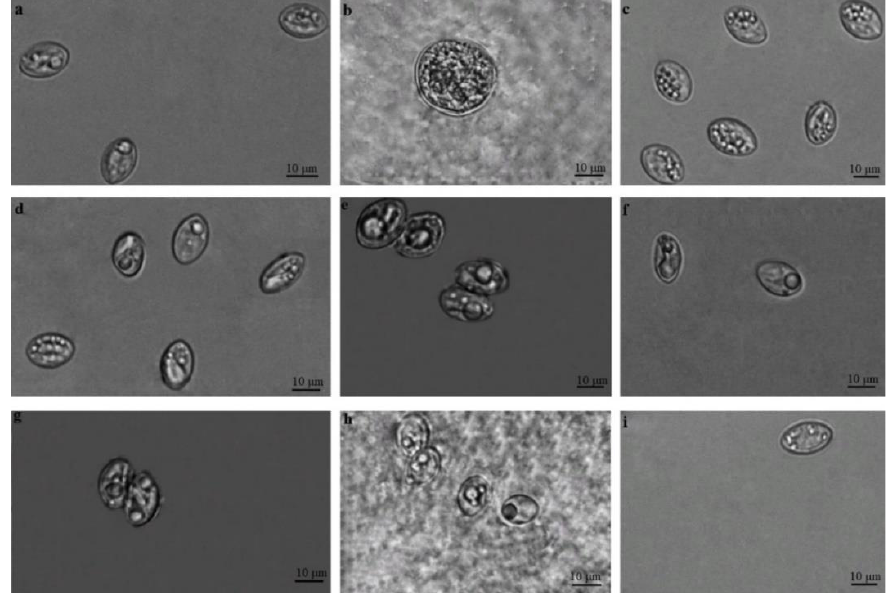
Figure 1. Oocysts/sporocysts found in small intestine mucosal scrapings of Mustelidae species. ( a , c , d , f , h , i ) Sporocysts. ( b) Oocysts. ( e , g , h ) Sporulated oocysts. Sarcocystis spp. from American mink ( a , b ), European pine marten ( c ), European polecat ( d,e ), European badger ( f , g ), and Beech marten ( h , i ).